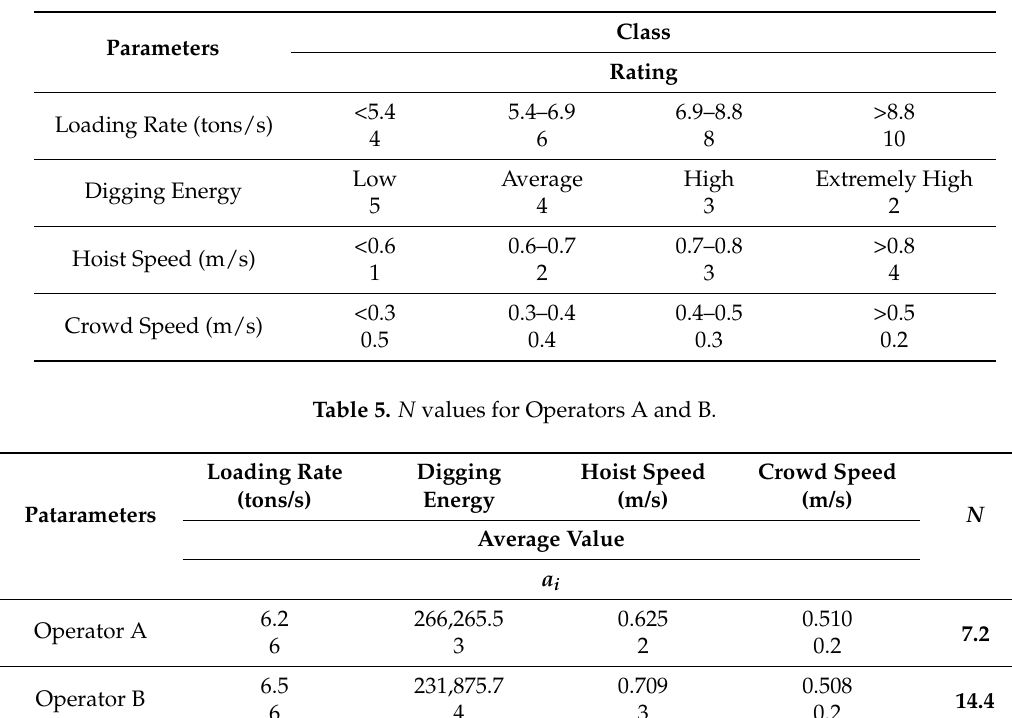
Table 4. Operator rating system.